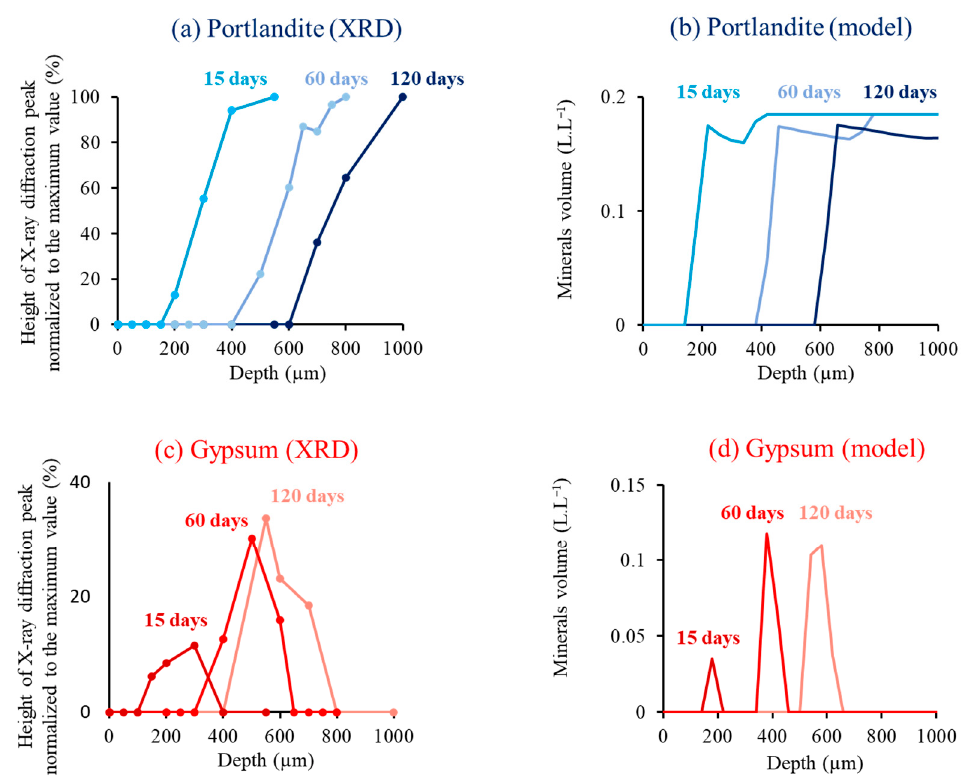
Figure 4. Evolution of the portlandite dissolution front ( a , b ) and gypsum precipitation front ( c , d ) over time obtained by XRD and modeling. XRD intensity profiles were plotted using the main peak of portlandite (2.62 Å) and gypsum (4.28 Å).